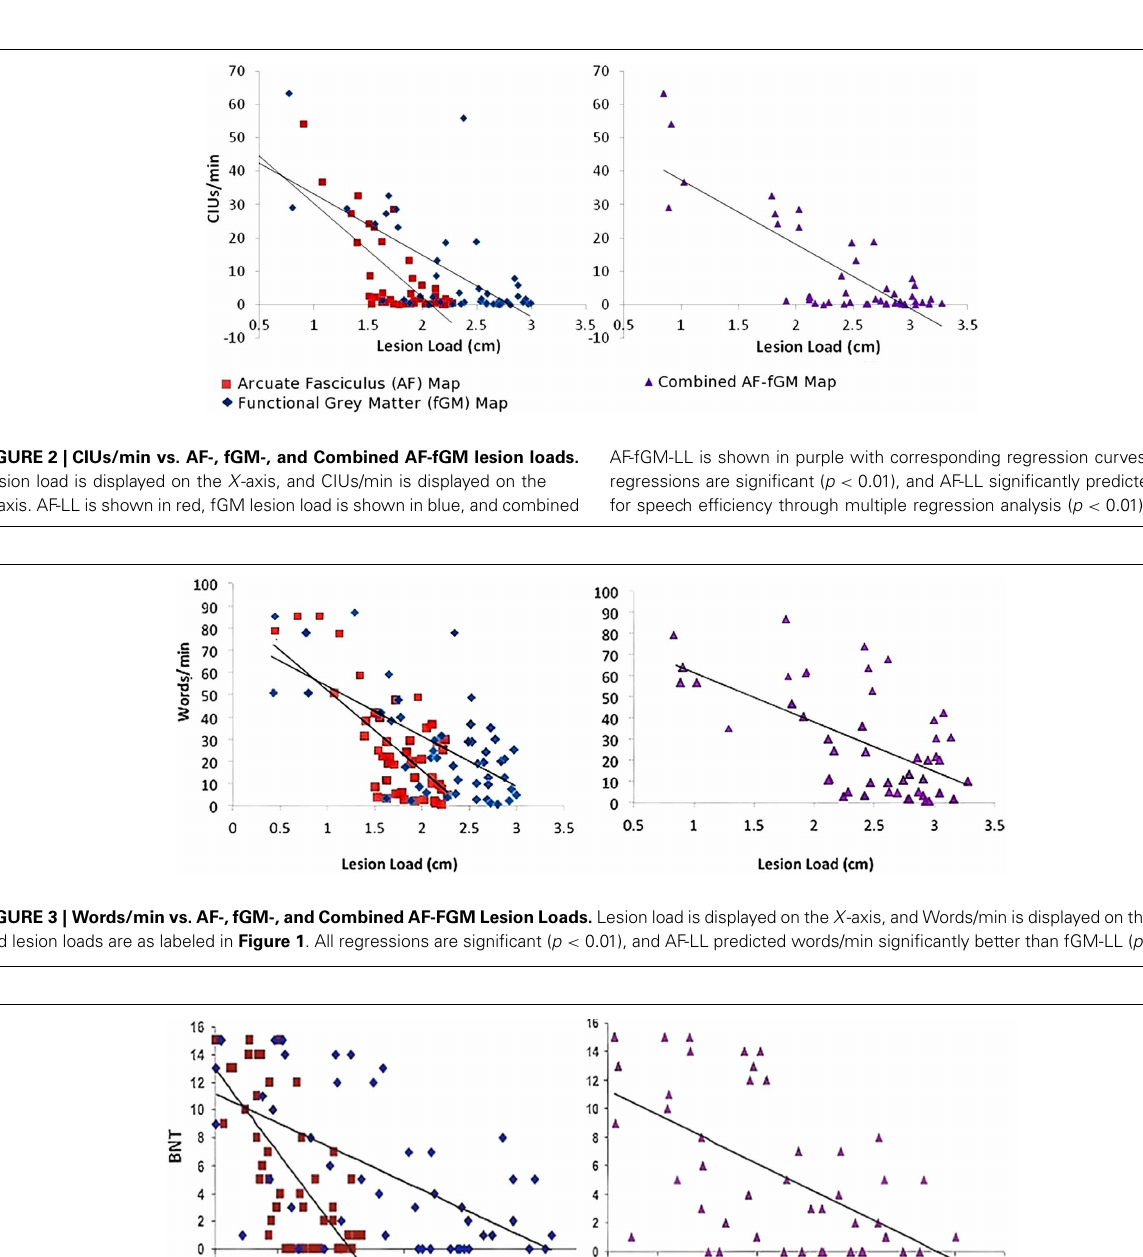
FIGURE 4 | Naming Ability vs. AF-, fGM-, and Combined AF-fGM Lesion Loads. Lesion load is displayed on the X -axis, and naming ability is displayed on the Y -axis; lesion loads are as labeled in